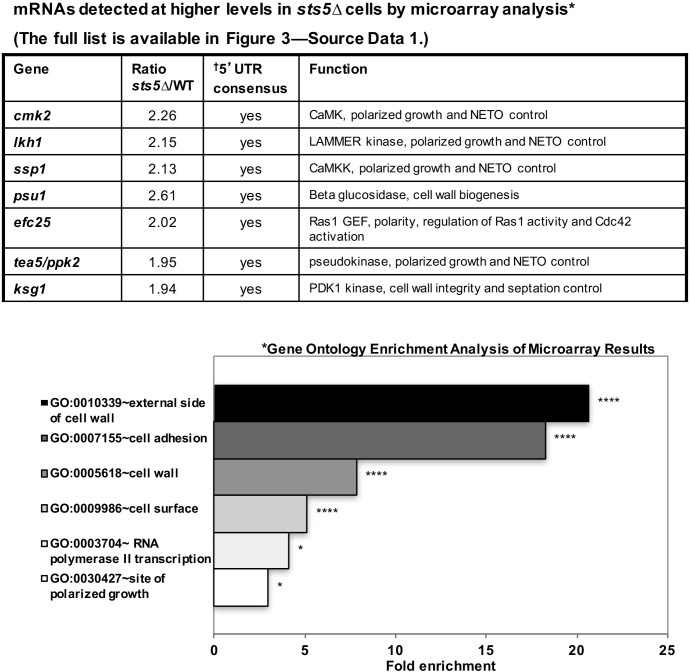
mRNAs detected at higher levels in sts5∆ cells by microarray analysis.Total mRNA was extracted from sts5∆ and control cells for microarray analysis. A complete list of mRNAs increased in sts5∆ cells (≥1.9 fold) is shown in Figure 3—source data 1. Several of these mRNAs have established functions in bipolar growth activation and contain putative Sts5-binding sites in their 5’ UTRs (Hogan et al., 2008; Wanless et al., 2014). *Gene ontology enrichment analysis of terms that are significantly enriched among the set of mRNAs with sts5Δ/WT ratio ≥1.90 in the microarray results. Fold enrichment plotted per gene ontology category among all significant terms (P<0.05, modified Fisher Exact P-value with the Benjamini P-value correction) for Cellular Compartment (CC), Biological Process (BP) and Molecular Function (MF) Gene Ontology terms. †Sts5 binding site: HNNYAHTCHWW (where H = A,T,C / N = A,T,C,G / Y = C,U / W = T,A).DOI:
http://dx.doi.org/10.7554/eLife.14216.00810.7554/eLife.14216.009Figure 3—source data 1.Microarray analysis results.A complete list of mRNAs detected at higher levels (≥1.9 fold) in sts5∆ cells by microarray analysis.